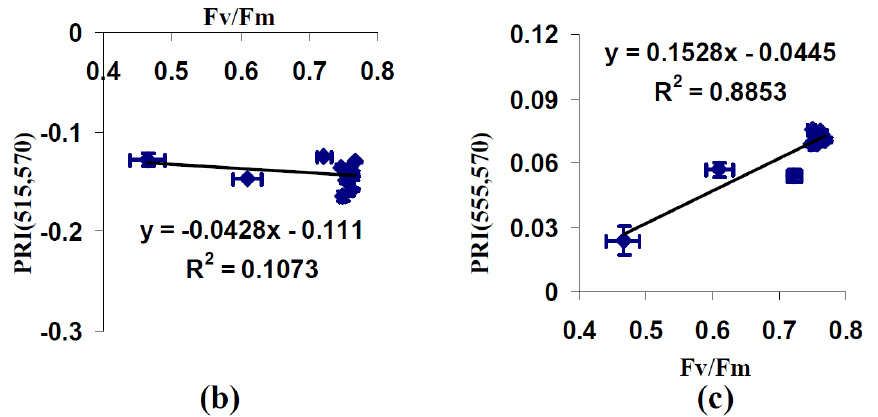
Figure 11. Dependence of Fv/Fm in leaves of wheat plants cultivated under open-ground conditions on duration of soil drought ( n = 45) ( a ) and dependences of average values of PRI(515,570) ( b ) and PRI(555,570) ( c ) in the canopy on Fv/Fm ( n = 12). Average values of PRI(515,570) and PRI(555,570) from Figure 9 were used. R 2 is the determination coefficient. *, difference between experimental and control indices was significant ( p < 0.05).